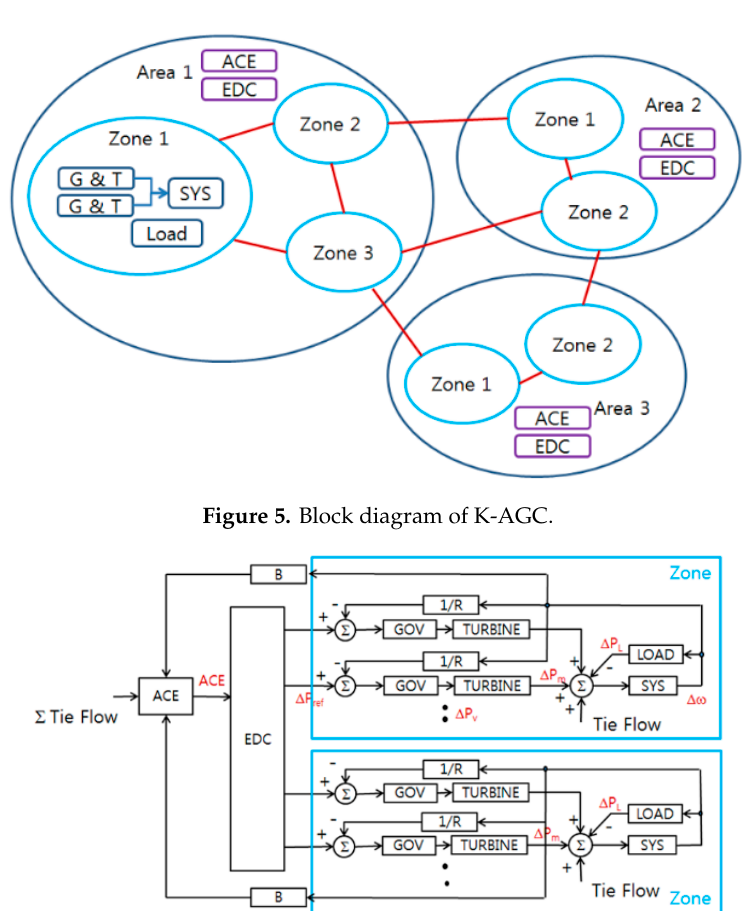
Figure 6. AGC configuration.